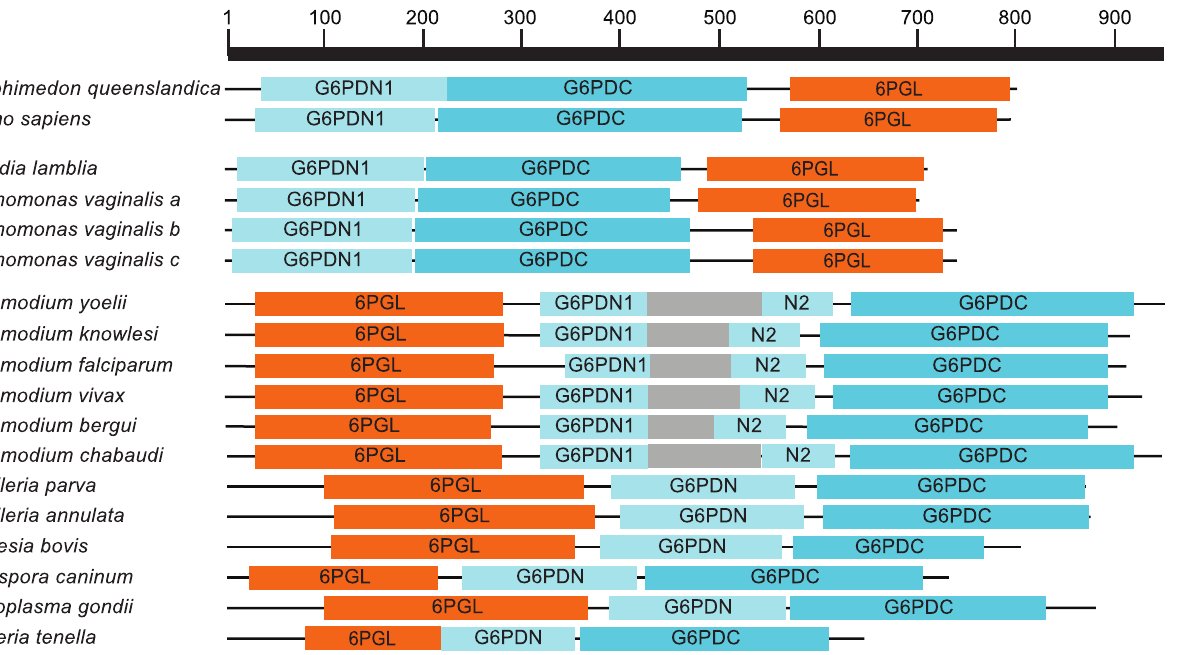
Figure 4. Fusions of the G6PD (N and C terminal regions) and 6PGL genes found in excavates, apicomplexans, and two representative H6PD/6PGL fusions in metazoans. Domains were identified using the Conserved Domain search feature at NCBI [19]. Amino acid length is shown at the top. Note the inverted orientation of the genes in excavates compared to apicomplexans and metazoans. The insert in the Plasmodium spp. G6PD domain is shaded. Accession numbers are given in Table